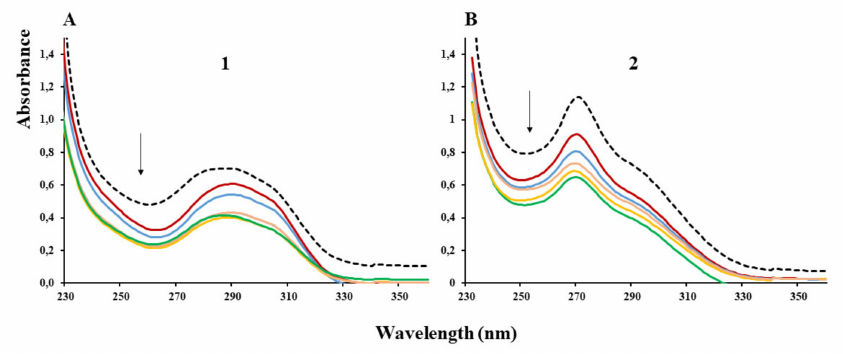
Figure 4. Absorption spectra of ( 1 ) ( A ) and ( 2 ) ( B ) in the absence of DNA (black dotted line) or in the presence of increasing DNA concentration (colored lines) (arrow indicates the directionality of [DNA] increase for 3 µ M complex